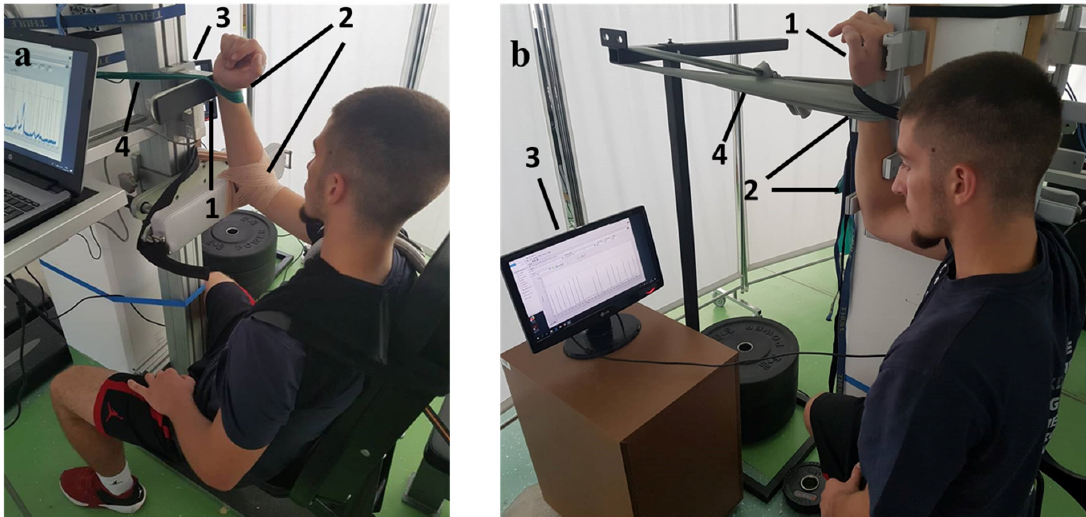
Figure 2. Measurement set-up: ( a ) Subject in the custom-built elbow extensor dynamometer. Subjects were seated (knee and hip in 90° position, trunk in upright position) on a bench with back support, while their shoulder and elbow were flexed at 90° in sagittal plane (forearm was in neutral position). The trunk and the shoulder of the performing arm were fixed to the back support, while the elbow was fixated to the lower support of the dynamometer. The force sensor was at the upper support, where the subject placed the wrist, which was fixated using elastic bands (to provide tension and proper contact between wrist and dynamometer support). ( b ) Subject in the custom-built volar flexor dynamometer. Subjects were seated on a chair. The subject’s shoulder and elbow were both flexed at 90°, while their forearm (pronated position) was placed in a custom-made dynamometer which allows full forearm fixation. Wrist was in neutral position. 1—force sensor, 2—joint fixations, 3—monitor for visual feedback, 4—elastic band